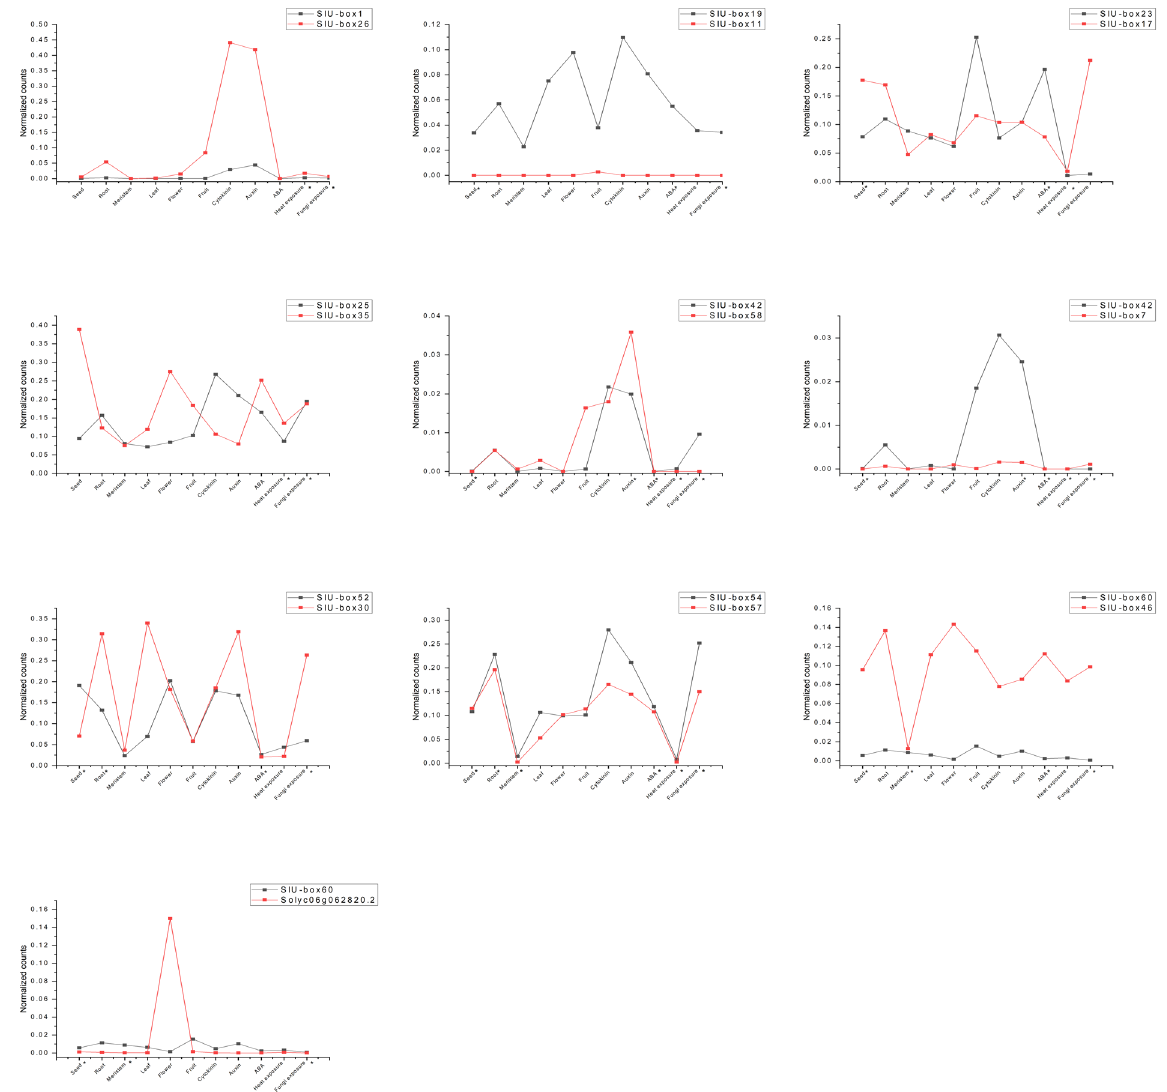
Figure 8. A comparative study of gene expression pattern between duplicated genes (total ten pairs) in seed, root, meristem, leaf, flower, fruit, cytokinin, auxin, abscisic acid (ABA), heat exposure (abiotic stress), and fungal exposure (biotic stress) treatments. The identified cis-elements conditions for the particular gene pairs are marked as ( *